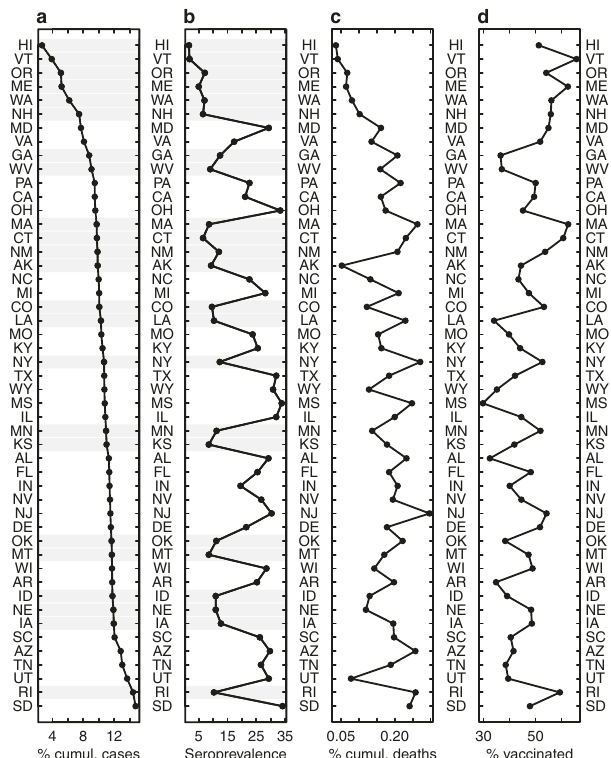
Fig. 1 | States ranked by different metrics. Ranked ( a ) cumulative percentage of the population reported as a COVID-19 case, b seroprevalence from the CDC nationwide serosurveys, c cumulative percentage of the population reported as a COVID-19death,and d vaccination(withafullseries)coverage,forJuly2021(round 24, the last round before the Roche assay started being used exclusively). Gray shading in ( a ) and ( b ) show serosurveys that at that point in time exclusively used the Abbott